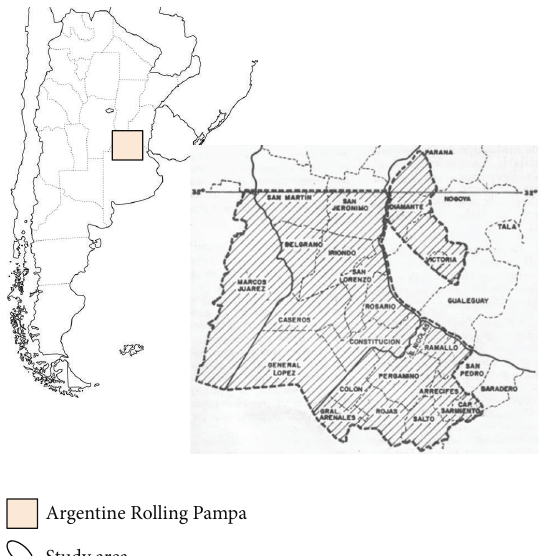
Figure 1: Argentine Rolling Pampa and study